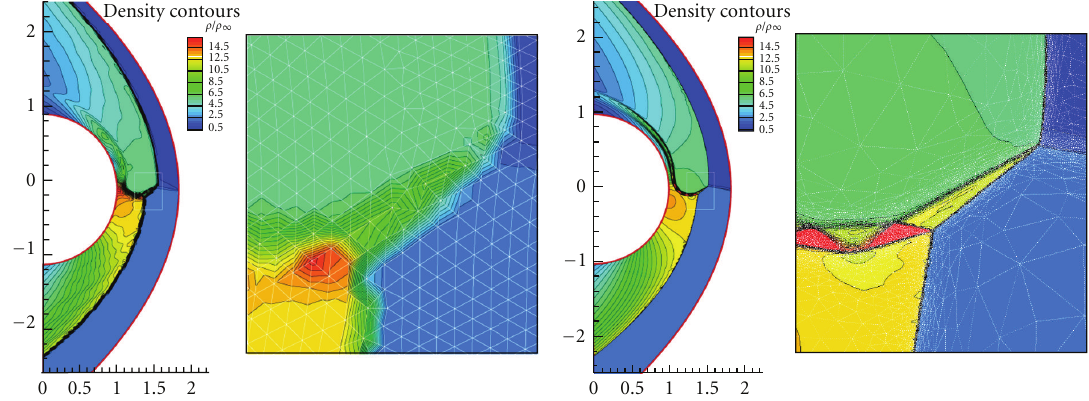
Figure 7: Type IV shock-shock interaction, M ∞ = 10: density